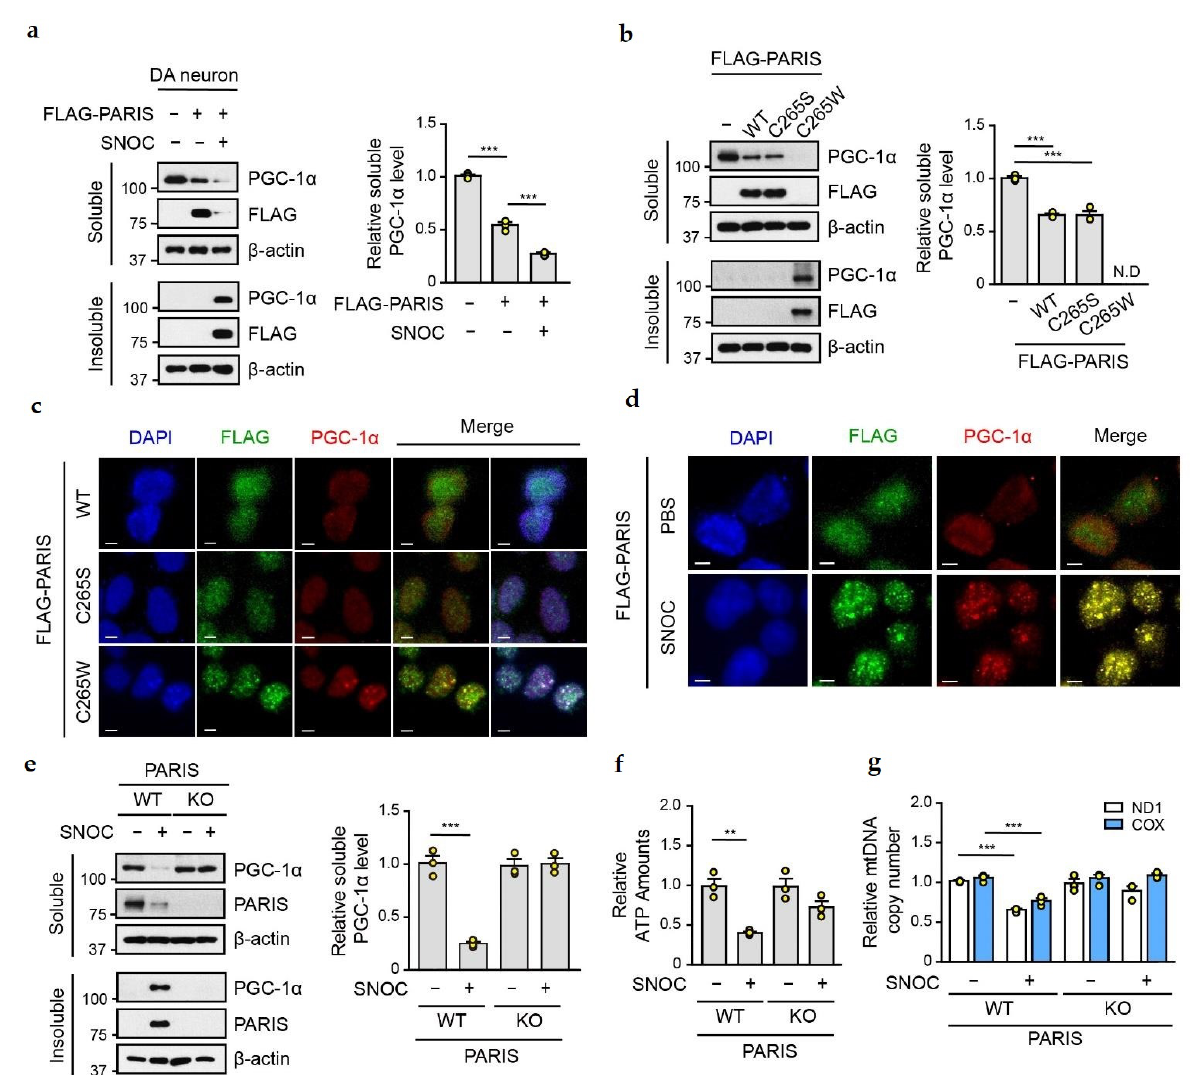
Figure 4. SNO-PARIS sequesters PGC-1 α in the insoluble fraction. ( a ) Cell lysates from primary DA neurons expressing FLAG-tagged PARIS were incubated with or without SNOC (50 µ M) for 30 min and then separated into RIPA-soluble and RIPA-insoluble fractions, followed by immunoblot assay. Right panel, relative PGC-1 α level in the soluble fraction normalized to β -actin ( n = 3). One-way ANOVA followed by Tukey’s multiple comparison test, *** p < 0.001. ( b ) Lysates of SH-SY5Y cells overexpressing FLAG-tagged PARIS WT and mutants (C265S, C265W) were sepa- rated into RIPA-soluble and RIPA-insoluble fractions, followed by immunoblot assay. Right panel, relative PGC- 1α level in the soluble fraction normalized to β -actin ( n = 3). One-way ANOVA fol- lowed by Tukey’s multiple comparison test, *** p < 0.001. N.D, not detected. ( c ) Representative immunofluorescence images of the FLAG-tagged PARIS WT and mutants (C265S, C265W) ex- pressing SH-SY5Y cells. PARIS in green and endogenous PGC- 1α in red. Scale bar = 5 μm. ( d ) Representative immunofluorescence images of SNOC (50 μM, 30 min) treated SH -SY5Y cells showing FLAG-tagged PARIS WT (green) and endogenous PGC- 1α (red) expression. Scale bar = 5 μm. ( e ) Lysates of PARIS Knockout (KO) SH- SY5Y cells treated with SNOC (50 μM) for 30 min were separated into RIPA-soluble and RIPA-insoluble fractions, followed by immunoblot assay. Endogenous PARIS and PGC- 1α levels were detected with indicated antibodies. Right panel , rela- tive PGC- 1α level in the soluble fraction normalized to β -actin level ( n = 3). Two-way ANOVA followed by Bonferroni’s post -test, *** p < 0.001. ( f ) Measurement of relative ATP levels in PARIS KO cells treated with or without SNOC (50 μM) for 30 min using the ENLITEN luciferase assay ( n =